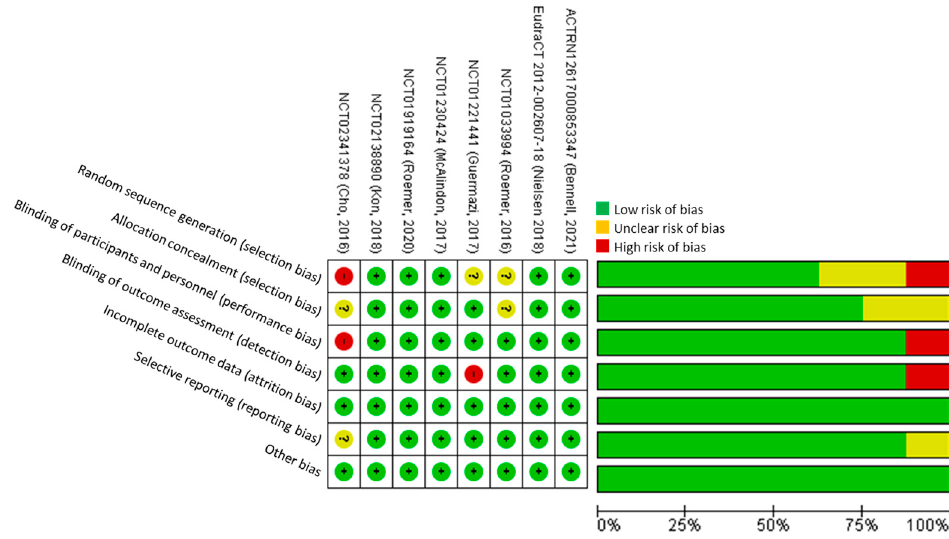
Figure 2. Cochrane risk of bias assessment.